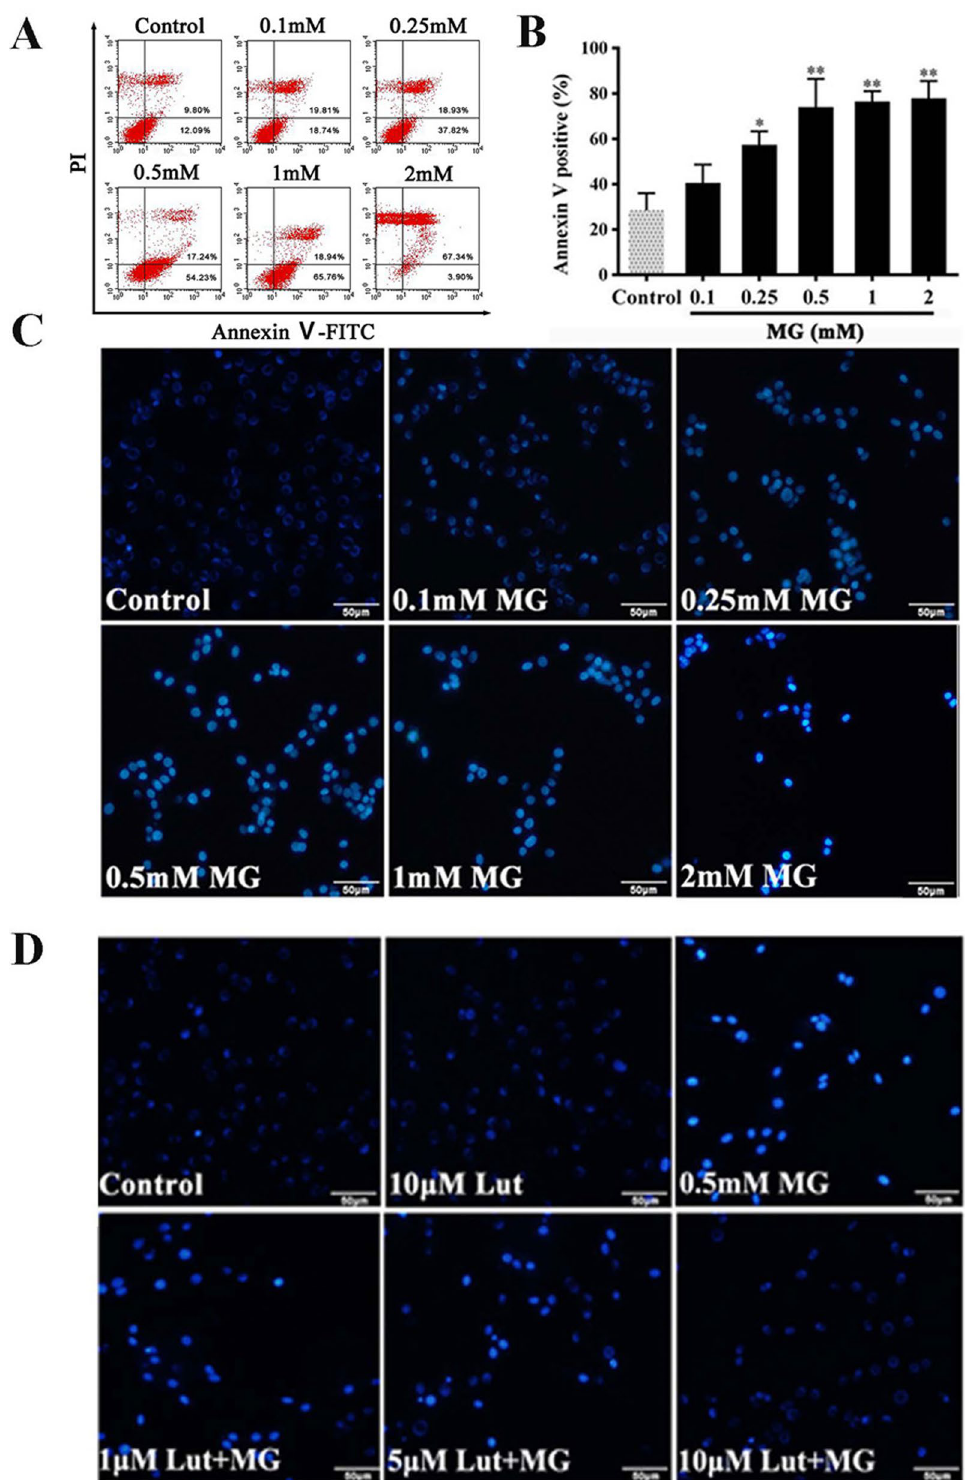
Figure 2. Luteolin (Lut) inhibited MG-induced cell apoptosis. Apoptosis assessment of PC12 cells treated with MG (0.1–2.0 mM) for 36 h. Lut protected PC12 cells against MG-induced apoptosis. ( A ) Cells were stained by fluorescent annexin V and propidium iodide (PI) and then examined for apoptosis by flow cytometry. ( B ) The percent of Annexin V positive cells following increasing concentrations of MG. Data are representatives from three independent experiments and the percentages of different populations were labeled in the figures. * p < 0.05 and ** p < 0.01 vs control group. ( C ) Nuclear fragmentation was assessed by nuclei staining with Hoechst 33358. MG (0.1–2 mM) increased the apoptosis in PC12 cells. ( D ) Cells were pretreated with Lut (1, 5, 10 μ M) for 3 h, followed by 0.5 mM MG exposure for 36 h. Morphological apoptosis was determined by Hoechst 33258